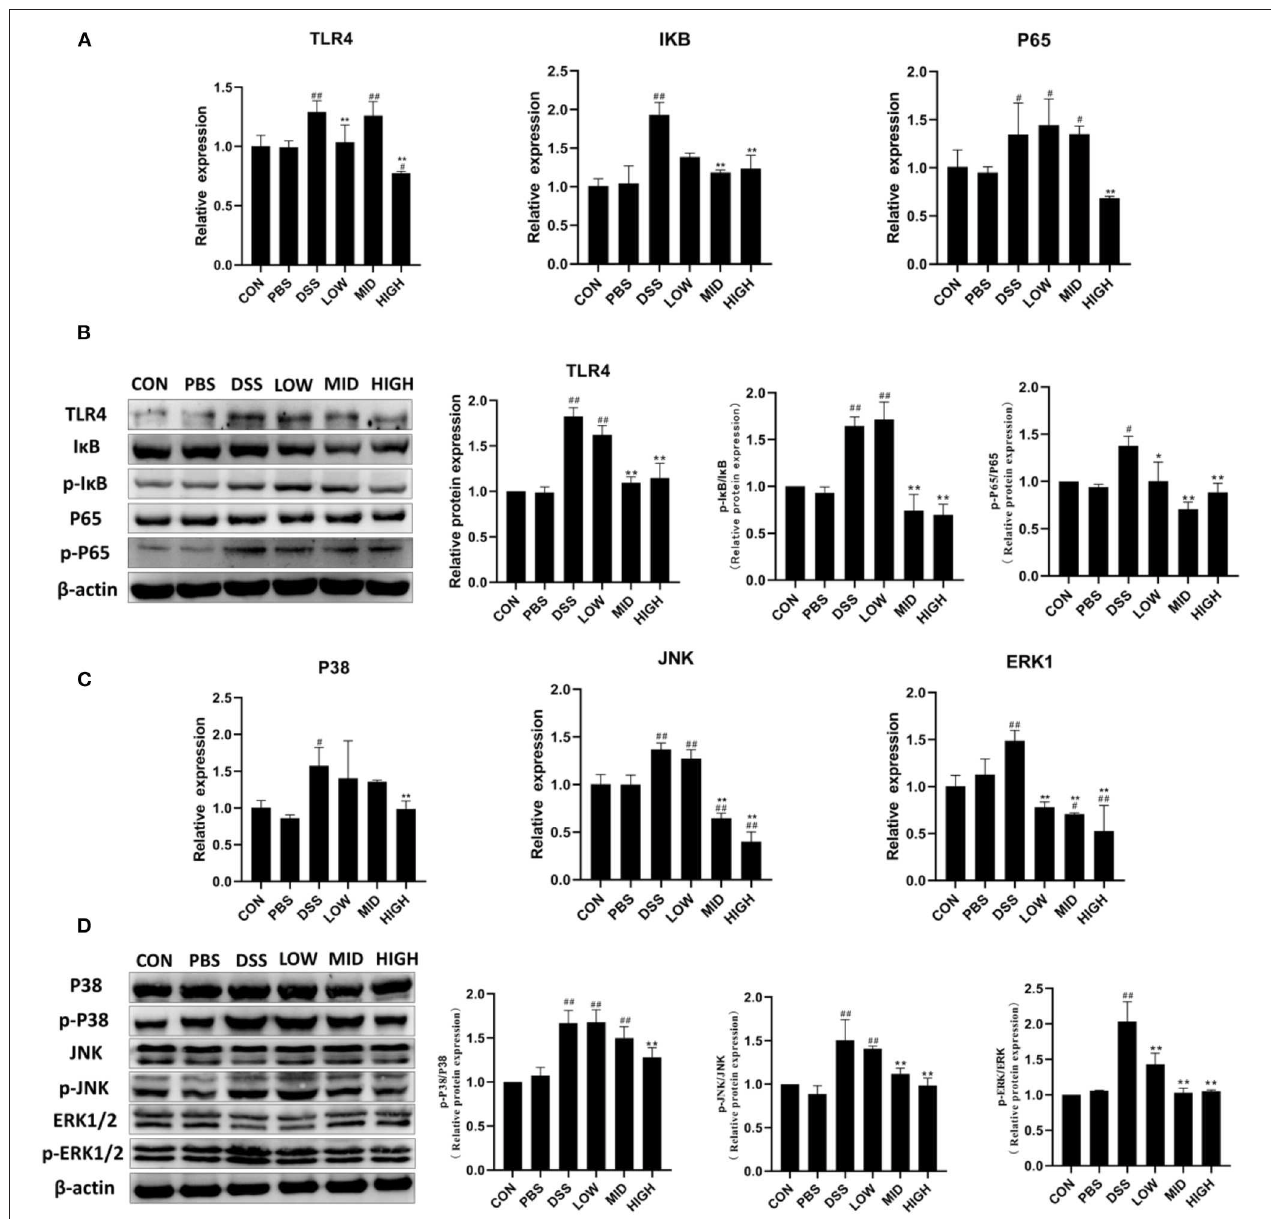
FIGURE 9 | The effect of BTL-1 on the intestinal NF- κ B and MAPK signaling pathways of IBD mouse model induced by DSS. The inhibitory effect of BTL-1 on TLR4/NF- κ B signaling pathway determined by qPCR (A) and western blotting (B) . The inhibitory effect of BTL-1 on the MAPK signaling pathway determined by qPCR (C) and western blotting (D) . The results were expressed as the means ± SEM of n = 3. # P < 0.05, ## P < 0.01, compared to control group, * P < 0.05, ** P < 0.01 compared to DSS